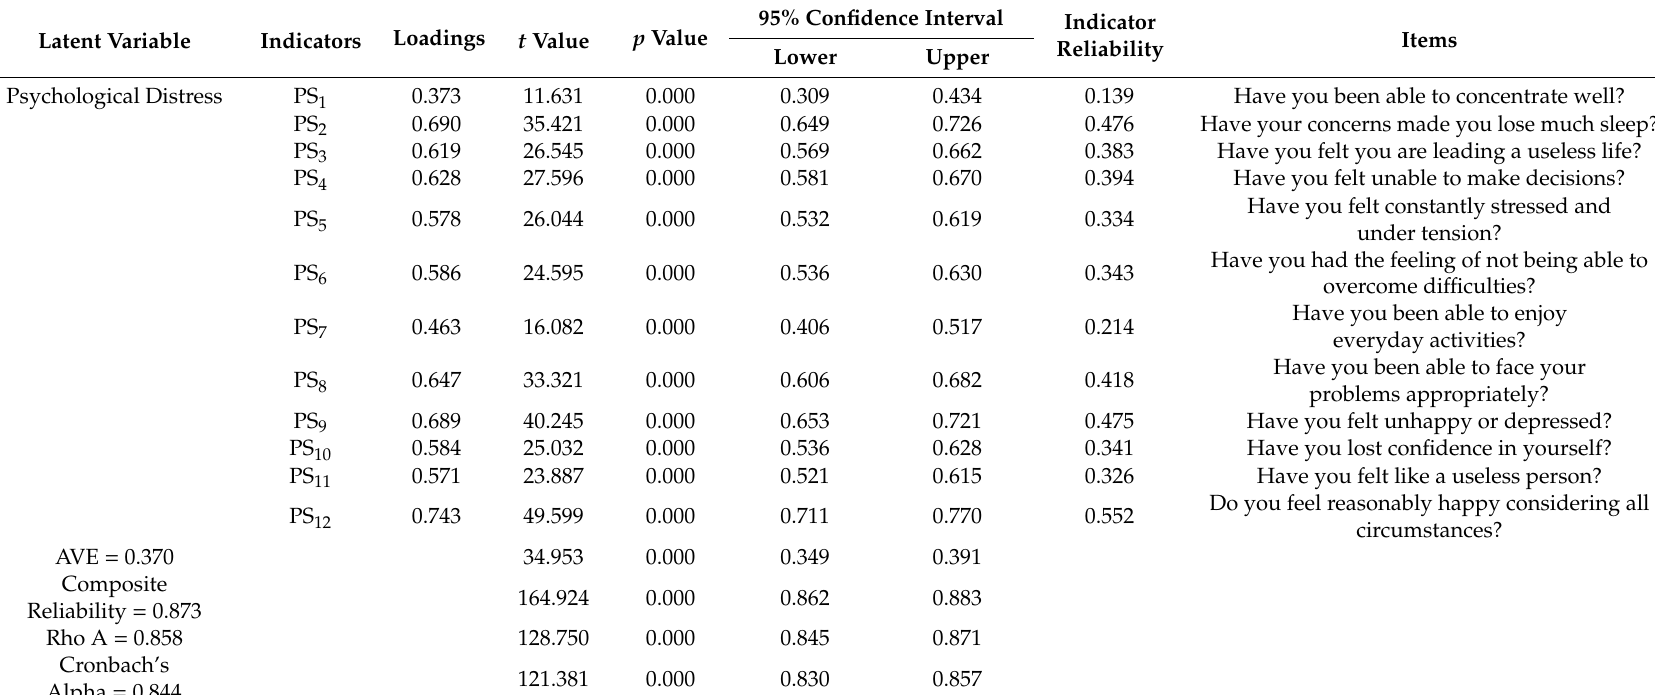
Table 1. Results summary from the reflective measurement model of psychological